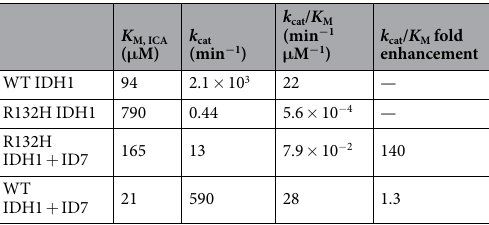
activity (Fig. 1c). In contrast, ID5 had a slight inhibitory effect, while the rest of the Fabs tested showed little to no effect on ICA conversion to α -KG (Fig. 1c). Detailed kinetic analysis reveled that excess ID7 enhances the ability